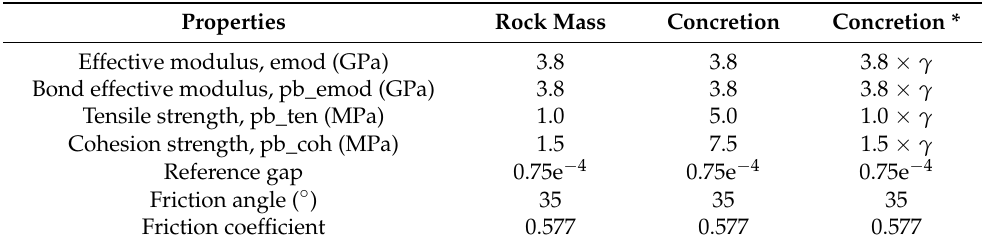
Table 1. Microscopic parameters of the linear model. Properties Rock Mass Concretion Concretion * Effective modulus, emod